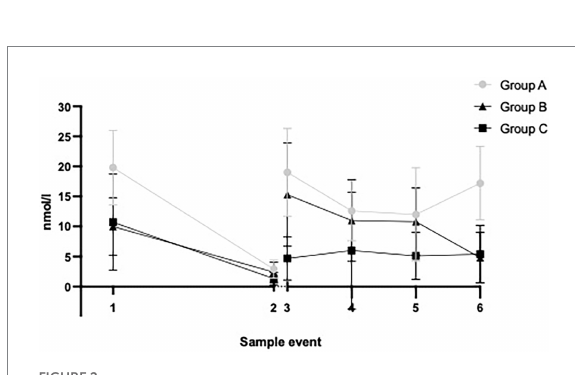
FIGURE 2 All groups over all events: 1–2 baseline, 3–6 during CAC (vertical bars one